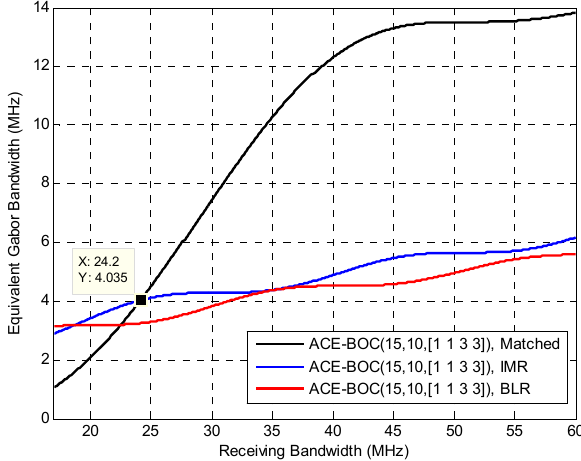
Figure 3. Equivalent Gabor bandwidth of ACE-BOC, where the central frequency of receiving of Matched receiving and IMR is at f 0 , and the central frequency of BLR is at f 0 − f sc . The IMR and BLR receives the component s LQ , whose power ratio among the useful transmitting power is 3/8.